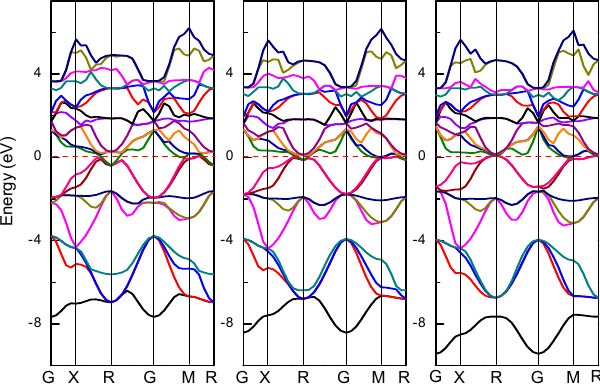
Figure 3. Energy band structures of Ti 3 AlN, Ti 3 InN, and Ti 3 TlN.